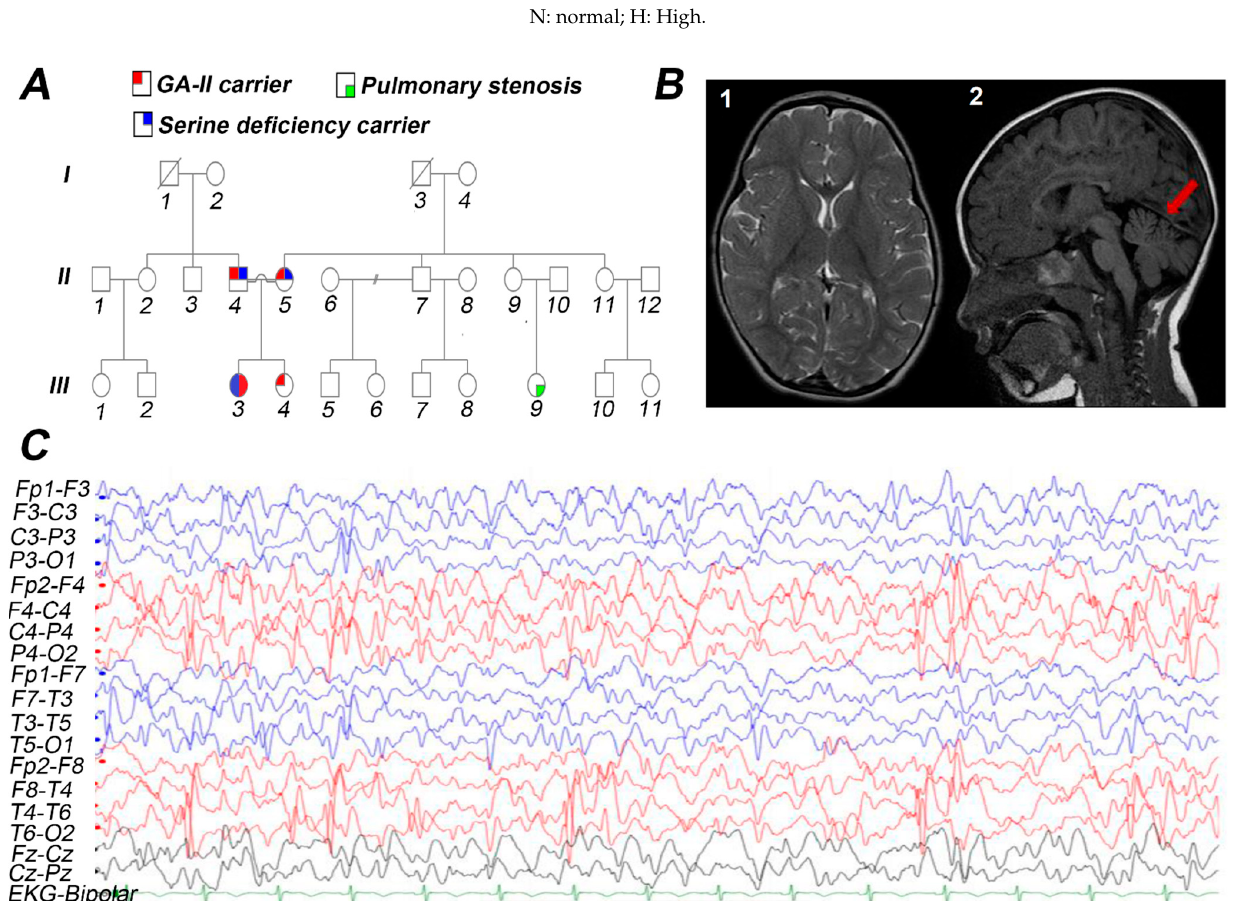
Figure 1. The detailed pedigree, EEG, and brain MRI of the index patient performed at 2.5 years of age. ( A ) Family pedigree of three generations affected with GA-II and serine deficiency. Male and female are represented by squares and circles, respectively. The proband is represented with a filled circle. ( B-1 ) Axial T2 shows normal basal ganglia; ( B-2 ) Sagittal FLAIR signifies mild cerebellar atrophy shown in red arrow. ( C ) EEG shows diffuse slow background with prominent right occipital spike and slow-wave discharges. Table 2. Plasma and CSF levels of serine and glycine of the patient before and after the treatment with L-serine.